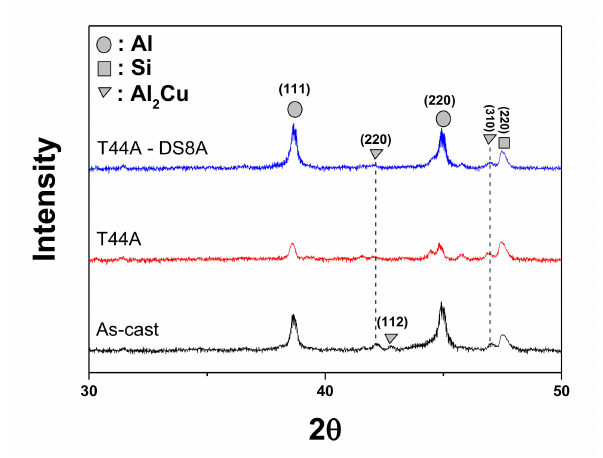
Figure 7. XRD (X-ray diffraction) profiles of the Al6Si2Cu alloy showing the diffraction peaks of the typical solution treatment.